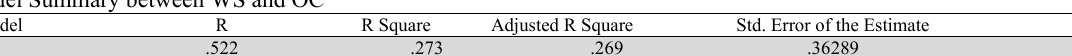
Model Summary between WS and OC